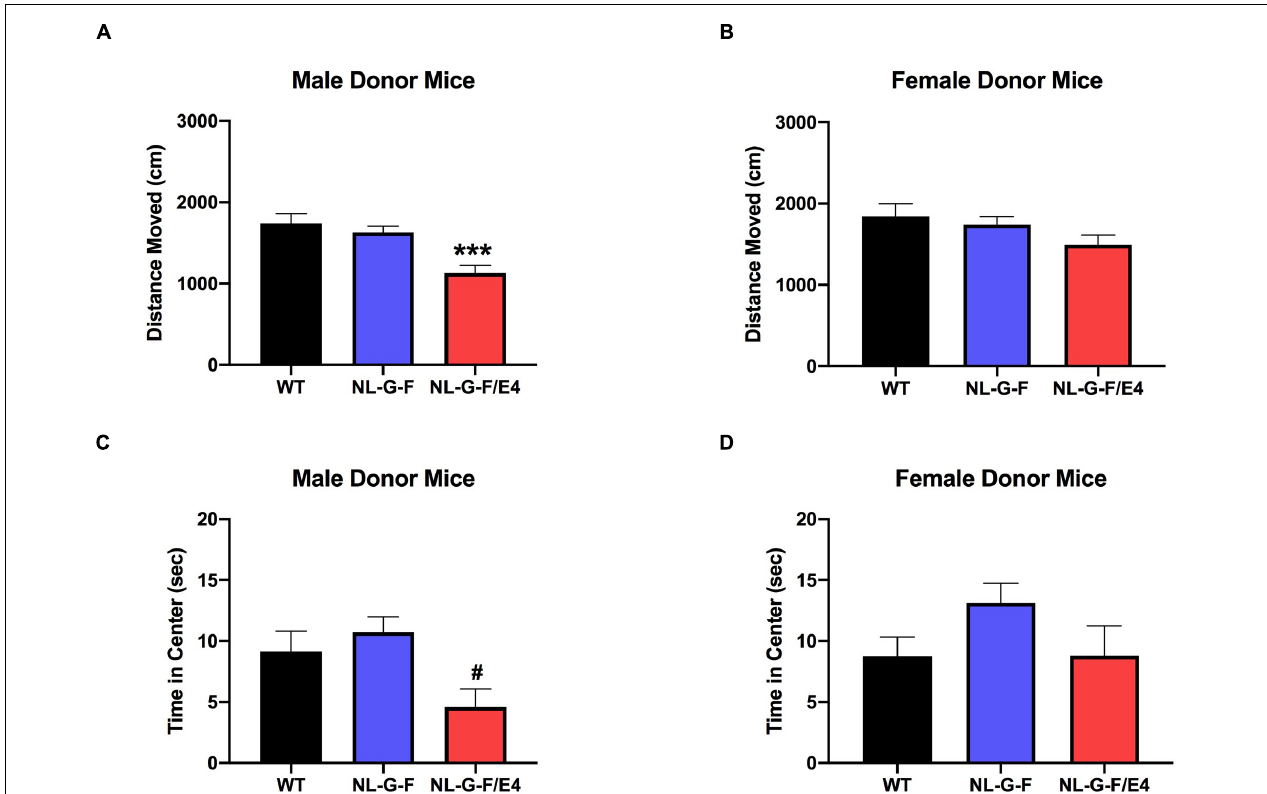
FIGURE 4 | (A) There was an effect of genotype on activity levels in male donor mice ( F (2,49) = 11.68, p < 0.0001). Activity levels were lower in App NL − G − F / E4 than WT mice *** p = 0.0003, Dunnett’s. (B) There was no effect of genotype on activity levels in female donor mice. (C) There was a trend toward less time spent in the center in App NL − G − F / E4 than WT male donor mice. # p = 0.0938, Dunnett’s. (D) There was no effect of genotype on time spent in the center of the open field in female donor